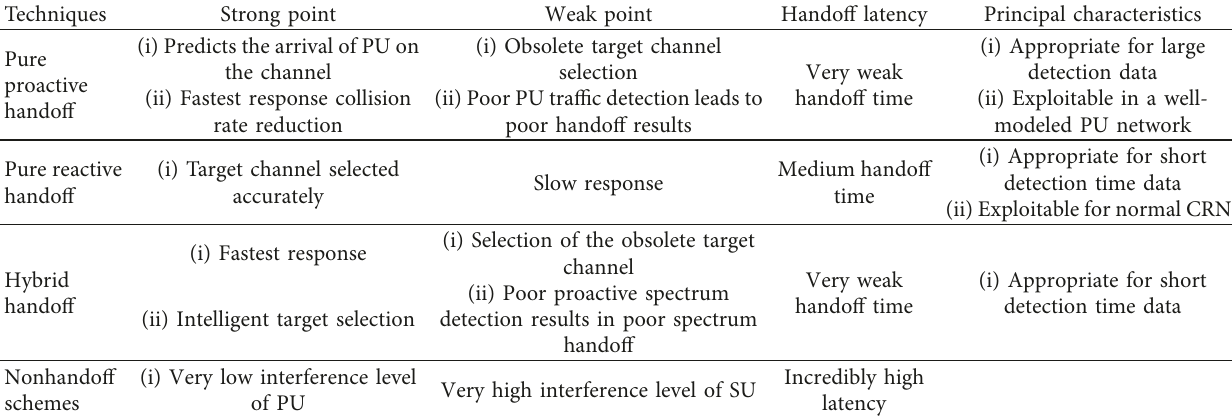
Table 1: Comparison of spectrum handoff